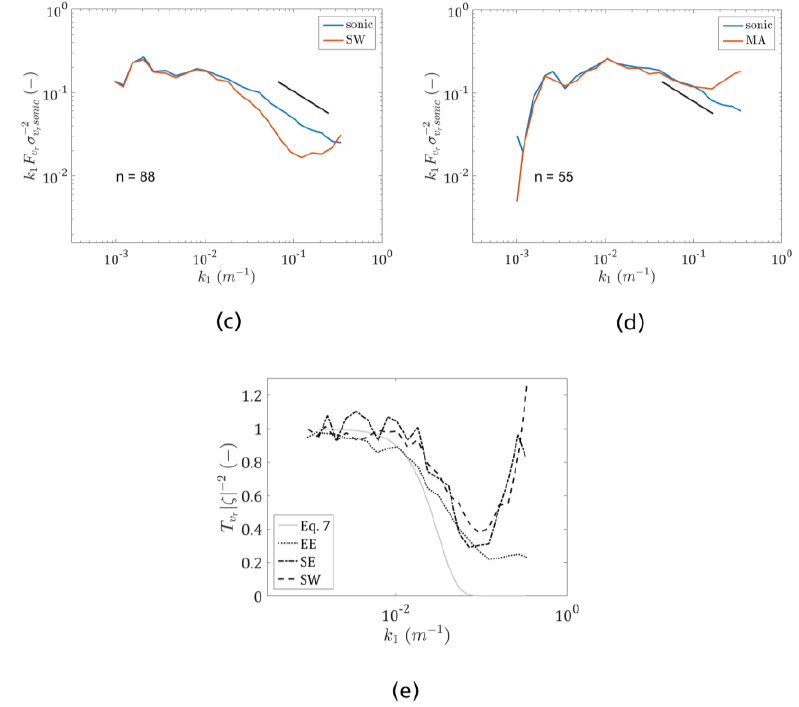
Figure 4. Spectra of v r measured by different WindScanners and the sonic anemometer when the wind direction was close to parallel ( ± 15 ◦ ) to the azimuth angle of the WindScanner ( a – c ); ( d ) spectra of the MA location and the w component of the sonic anemometer; sonic time series have been aggregated to 0.5 Hz before calculation of the spectra to account for the temporal averaging effect and the associated filter function ˆ ζ ( k 1 ) ; the black line indicates the theoretical − 2/3-slope in the inertial subrange; − 2 (cid:12) (cid:12) T v ( e ) spectral transfer function derived from the average of the normalised spectra in ( a – c ); (cid:12) ˆ ζ (cid:12) r only periods with u sonic > 4 m · s − 1 and u (cid:48) 2 sonic > 0.2 m 2 · s − 2 (SW, SE, EE), and w (cid:48) 2 sonic > 0.1 m 2 · s − 2 (MA) were used in the spectral averaging; n indicates the number of periods used for